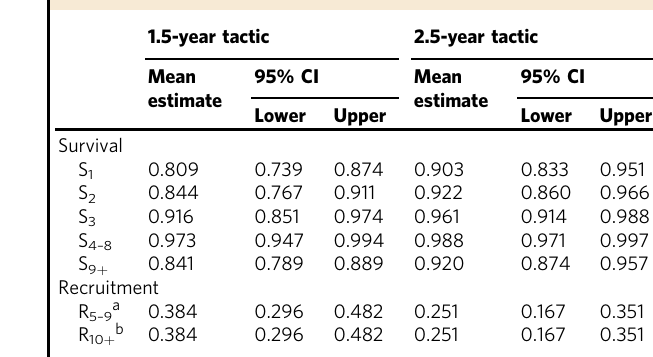
Table 2 Bootstrapped model-based predictions (back- transformed on the original scale) of tactic- and age class- speci fi c demographic rates for female brown bears in